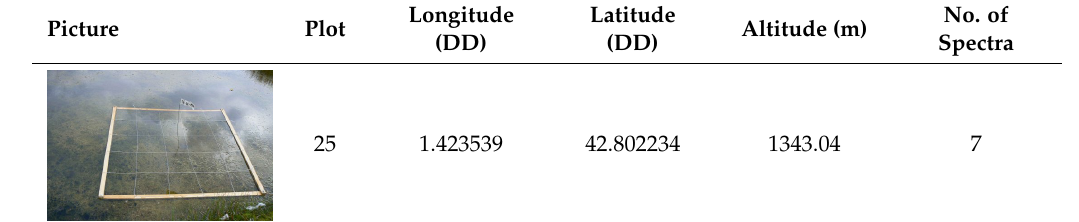
Table A11. Pictures, plots, geographic coordinates and number of spectra of Aquatic type b (AQ_B).